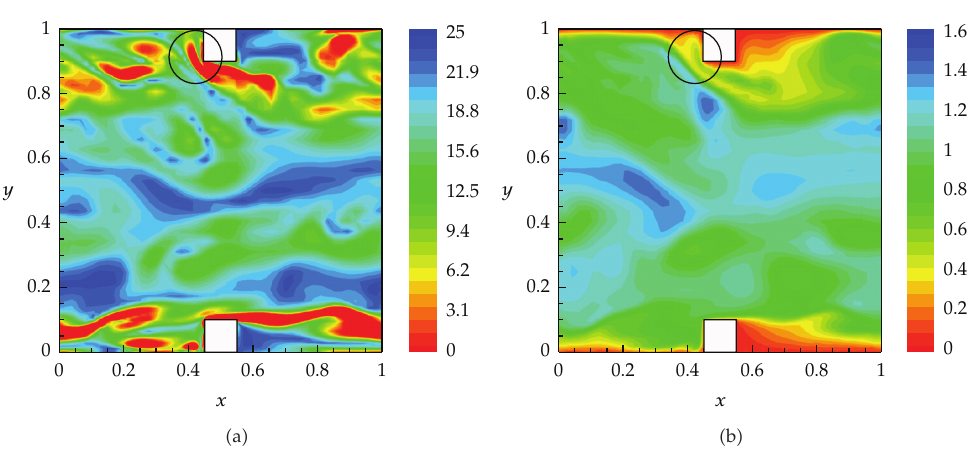
Figure 7: Instantaneous moduli of vorticity and temperature distribution on cross-sectional plane at z (cid:8) 0 . 5. (cid:2) a (cid:3) modulus of vorticity, and (cid:2) b (cid:3) temperature field.